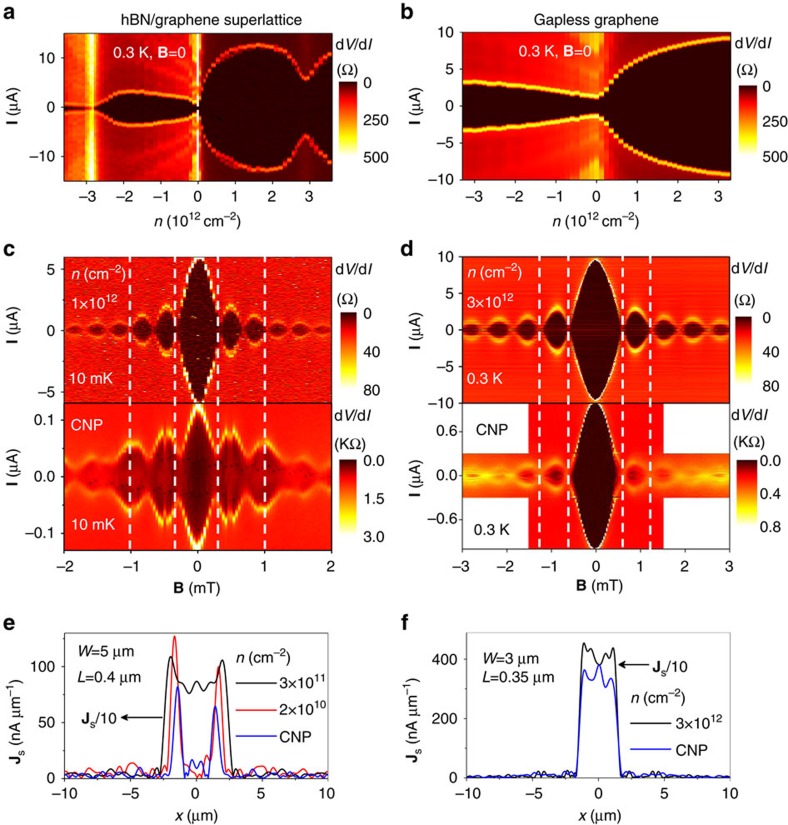
Interference patterns and supercurrent flow in gapped and non-gapped graphene monolayers.(a) Differential resistance as a function of carrier concentration n and applied current I for a Nb-MLG-Nb junction (5 μm wide and 0.4 μm long). The gap is induced by alignment with the bottom hBN crystal. (b) Same for encapsulated but nonaligned monolayer graphene (the junction is 3 μm wide and 0.35 μm long). (c) Interference patterns for gapped MLG at relatively high doping (top panel) and at the CNP. (d) Same for non-gapped graphene. (e,f) Corresponding spatial profiles of the supercurrent density (Js). They were calculated using experimental patterns such as shown in c,d. Note that graphene edges in e support fairly high supercurrent at the CNP, whereas there is no indication of any enhanced current density along edges for the non-gapped case in f.